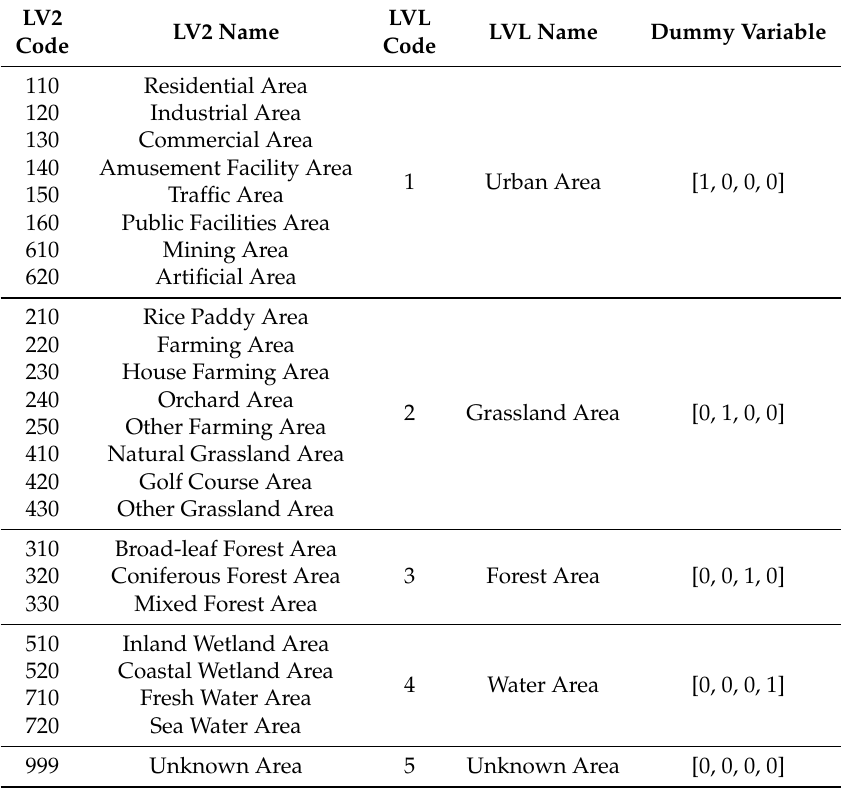
Table 5. Topographic